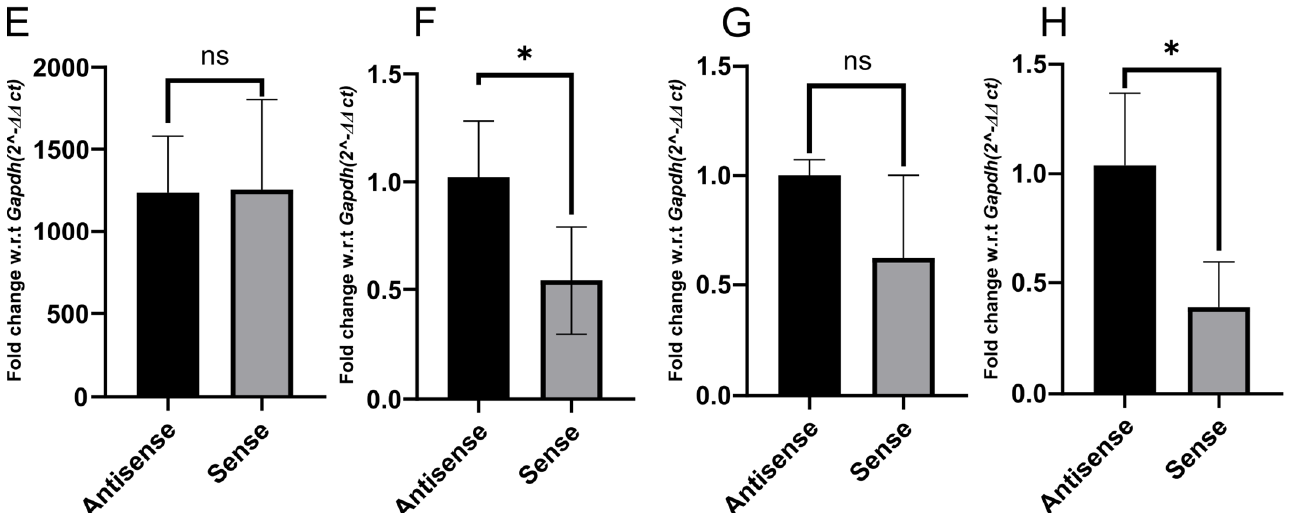
Figure 7. Kalnc2 overexpression in N2A cells downregulates major Kalrn transcript expression. ( A , C ) A schematic of a bidirectional promoter plasmid containing Kalnc2 and an RFP tag. ( B , D ) Kalnc2 sense and antisense overexpressed RFP-positive cells, respectively. ( E – H ) Expression of Kalnc2 , Kal7, Kal9, and Kal12, respectively, normalized by Gapdh in sense and antisense conditions (Data are shown as mean ± SD; N = 3 biological replicates; n = 3 technical replicates; t -test, * p <